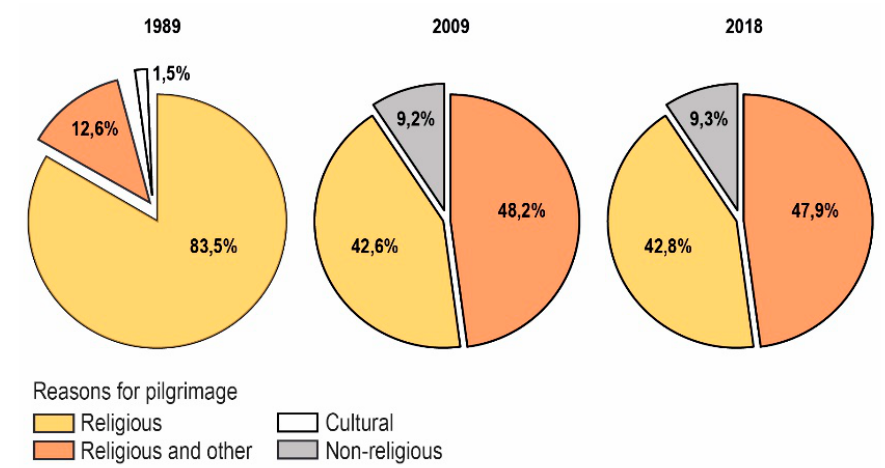
Figure 6. Reasons for pilgrimage. Comparison between 1989, 2009, and 2018. Source: Pilgrim’s Reception O ffi ce in Santiago de Compostela. It should be noted that data areunavailable for 2.4% of the pilgrims in